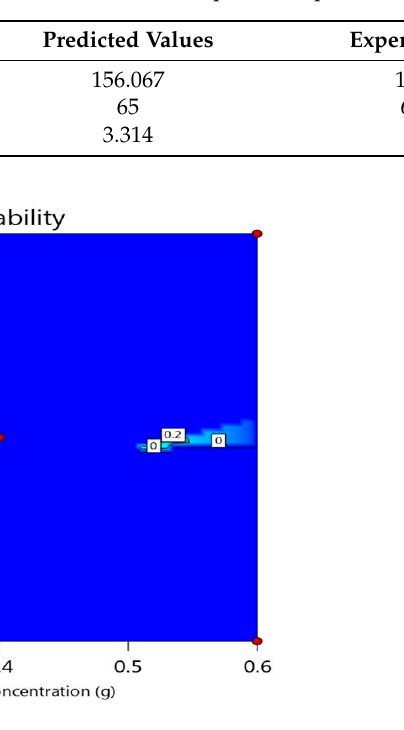
Table 5. Predicted and observed experimental value of response at optimized conditions.